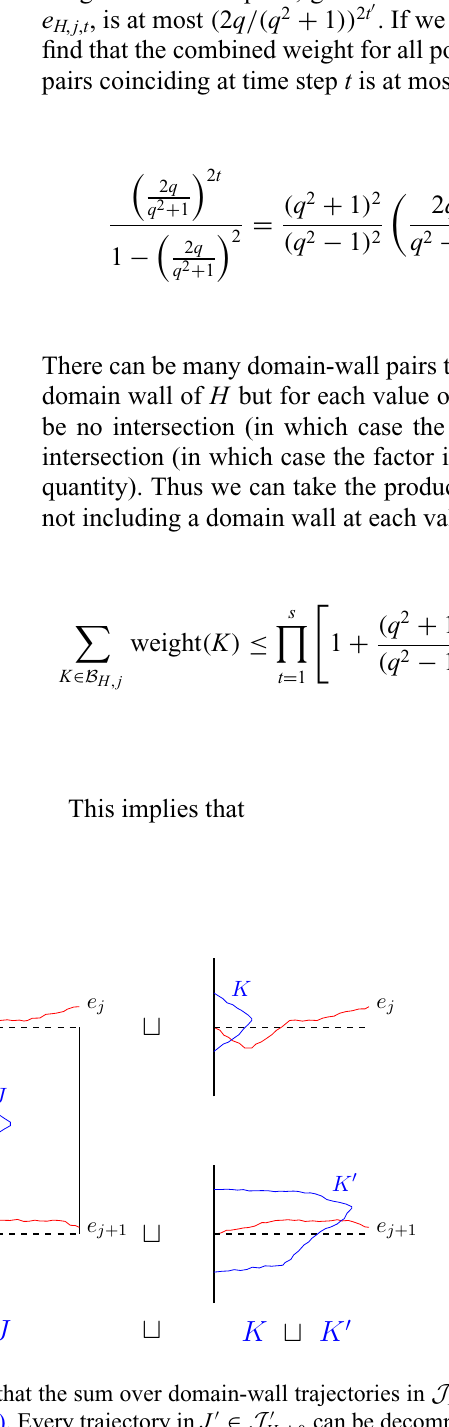
can be decomposed into a trajectory H , j ,0